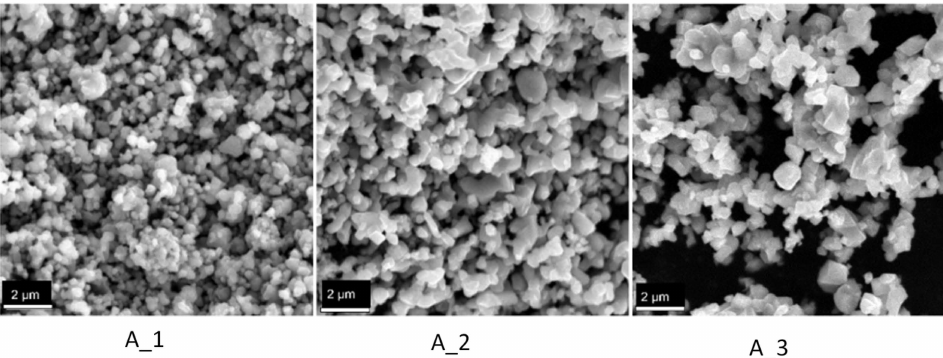
Figure 2. SEM images obtained for the samples A_1 (600 ◦ C for 48 h), A_2 (800 ◦ C for 48 h) and A_3 (1000 ◦ C for 48 h).